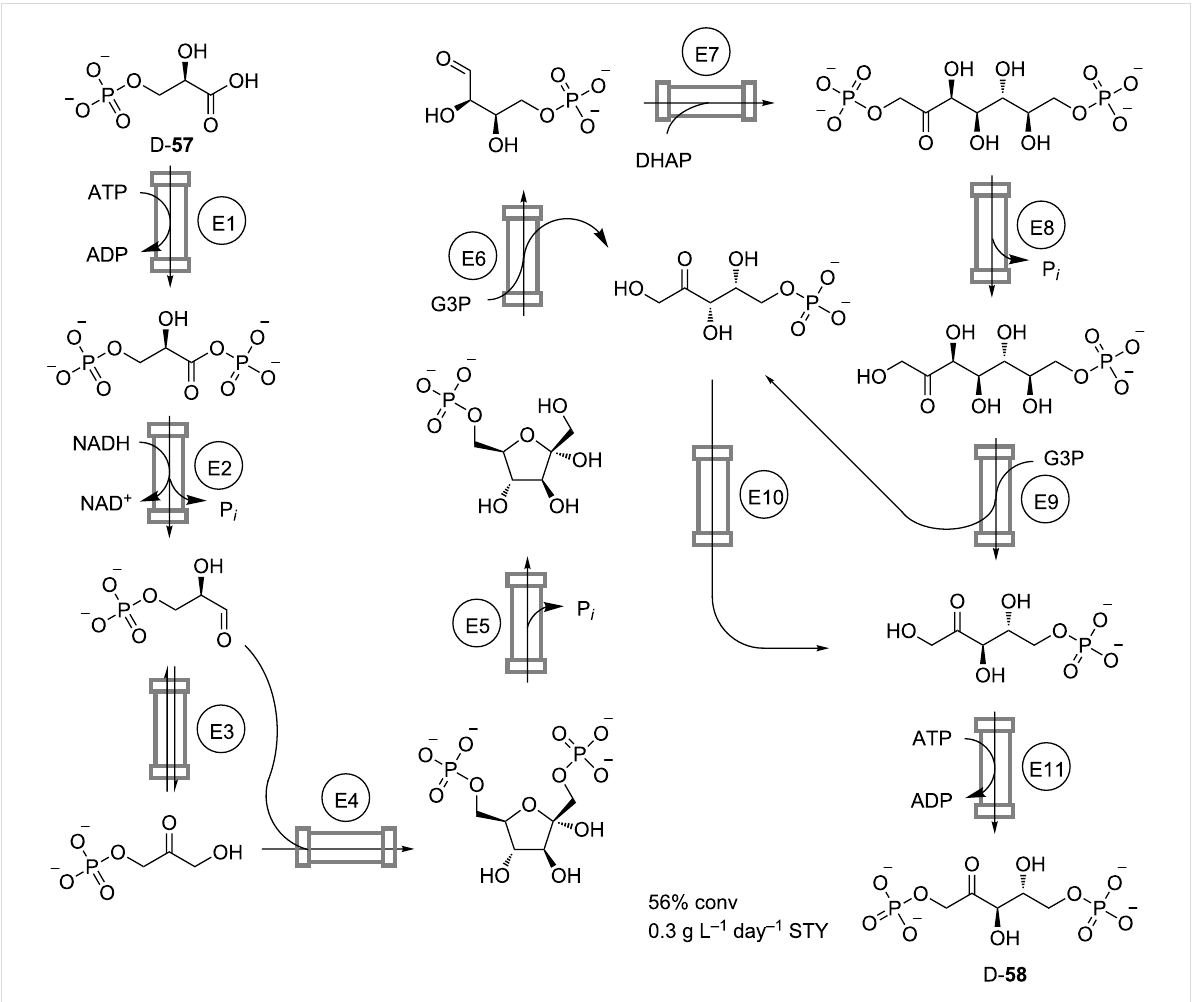
Scheme 17: Continuous conversion of 3-phospho-D-glycerate ( 57 ) into D-ribulose 1,5-bisphosphate ( 58 ) in a cascade of packed-bed reactors. E1: Phosphoglycerate kinase; E2: Glycerate phosphate dehydrogenase; E3: Triose phosphate isomerase; E4: Aldolase/FBP; E5: